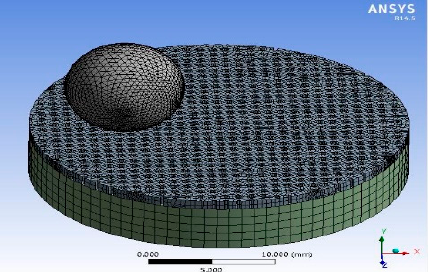
Figure 4. Analysis simulation model of the pocket-textured disc and bearing steel ball.